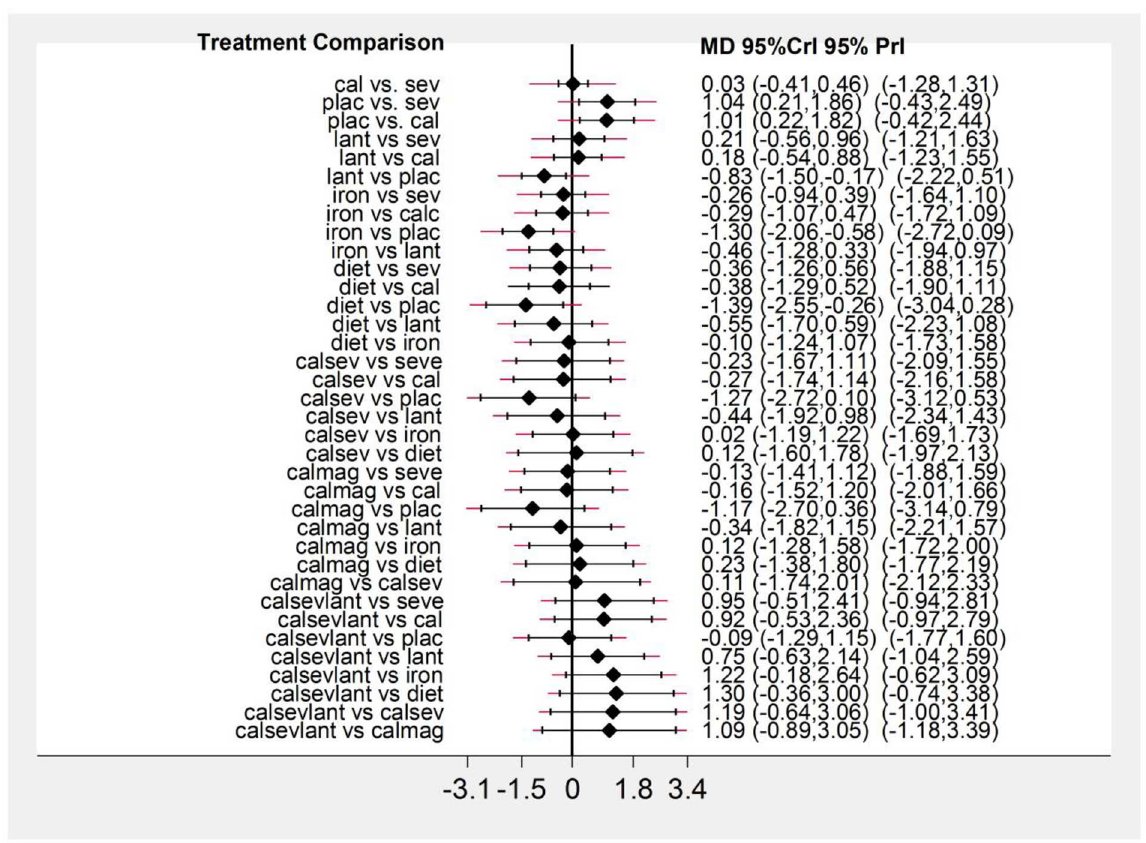
Fig 4. Network meta-analysis results for serum phosphate. Forest plot of effectiveness outcome for mean phosphate reductionat the end of the study period. MD: Mean difference; Crl: Credibleinterval; PrI: predictiveintervals.